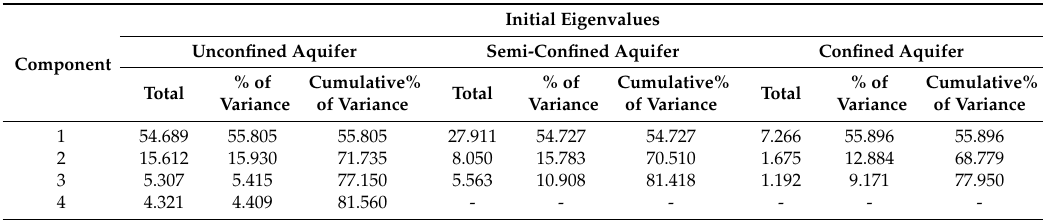
Figure 5. Factor scores for the first principal component and groundwater hydrograph of the example site pairs of each aquifer characteristic: ( a ) unconfined aquifer, GimpoGimpo; ( b ) semi-confined aquifer, JecheonGoam; and ( c ) confined aquifer, SeoulMagok. Table 4. Total variance of water-level data as explained by the PCA from the 63 pairs of monitoring wells which characterized aquifer conditions by the spectral analysis.